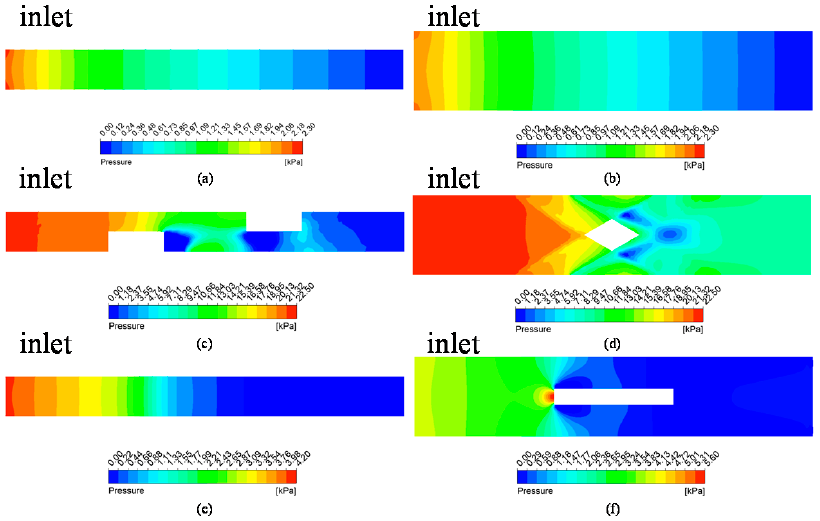
Figure 8. The pressure drop contours on the horizontal ( a , c , e ) and longitudinal ( b , d , f ) cross-sections: ( a , b ) MC-R; ( c , d ) MC-CR; ( e , f ) MC-HR.